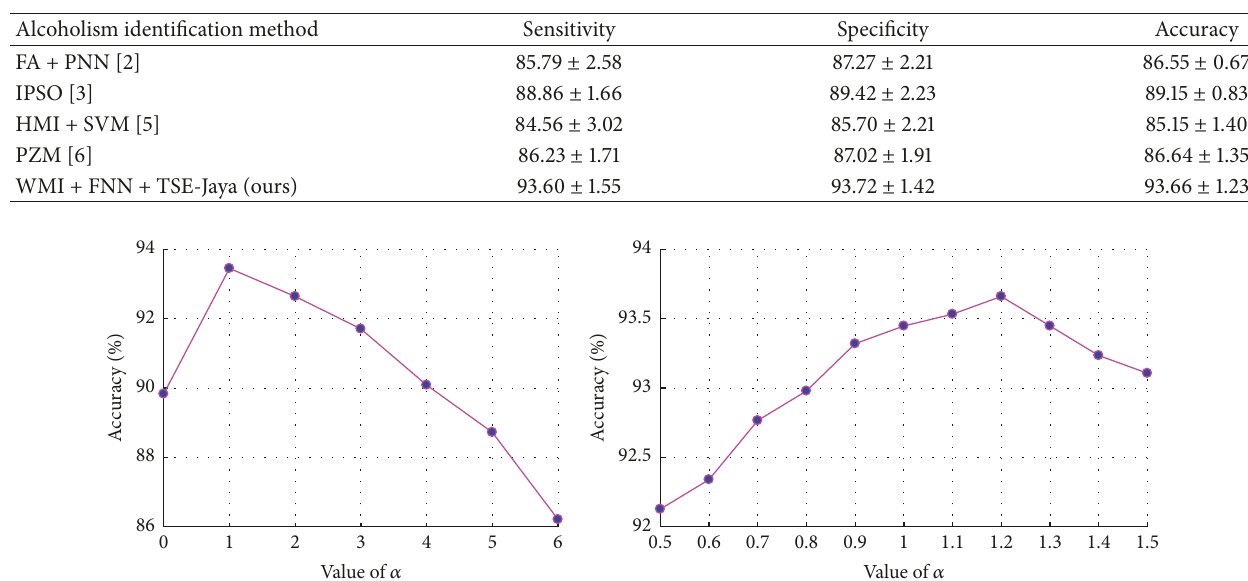
Table 7: Method comparison.